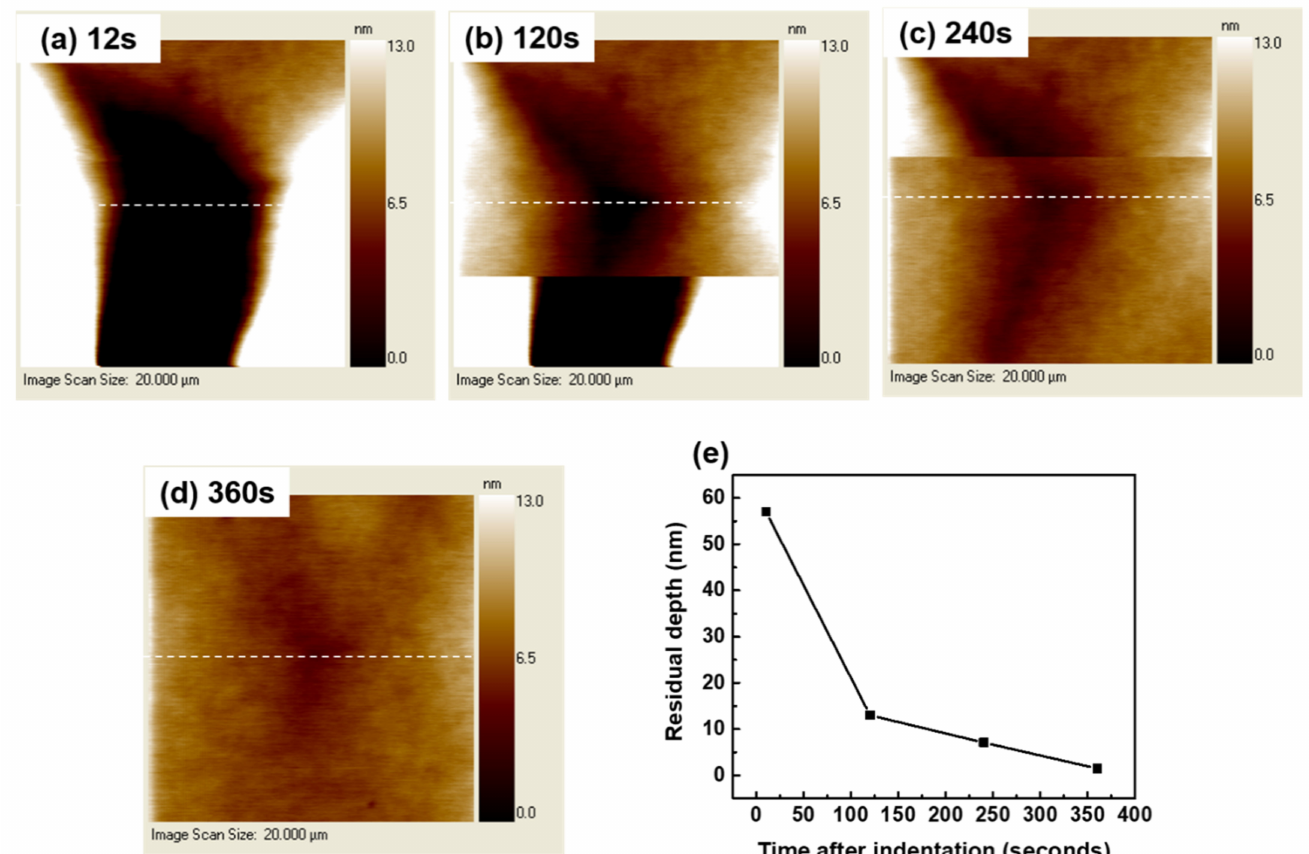
Figure 5. ( a – d ) Surface images of PU topcoat with different time after indentation and ( e ) height profiles along the lines marked on the images with different